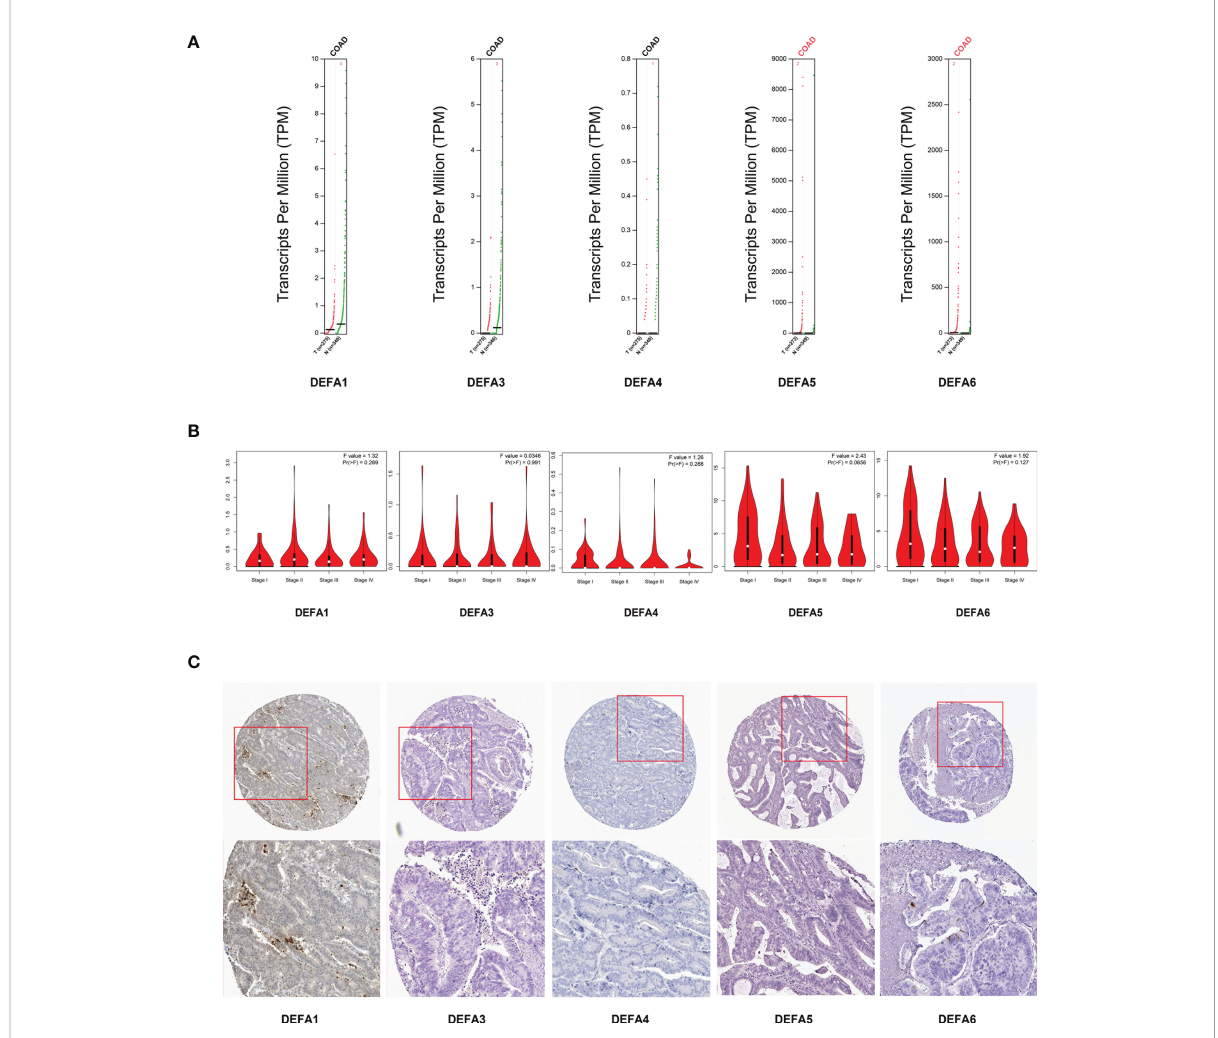
FIGURE 5 Relationship between the mRNA levels of DEFAs and the clinicopathological parameters of patients with CRC. (A) Transcription levels of DEFA factors in CRC (GEPIA2); (B) Correlation between DEFAs expression and tumor stages in CRC patients (GEPIA2); (C) Protein expression of DEFAs in CRC patients